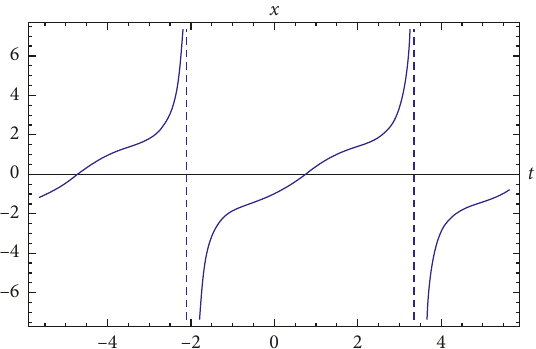
Figure 2: Comparison between the exact solution and the numerical solution for Example